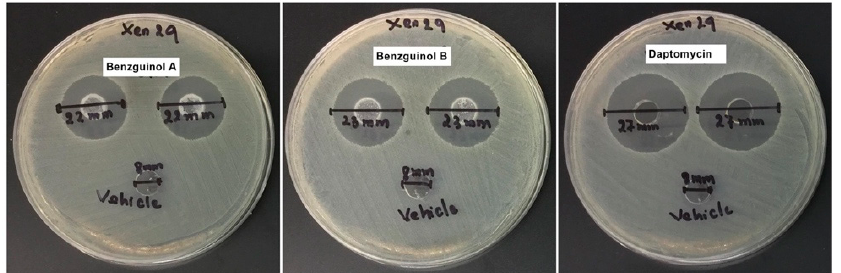
Figure 6. Selected well diffusion of benzguinol A and benzguinol B formulations used in efficacy trial. Each well contained 100 μ L of each formulation of benzguinol A or B (600 μ g) , daptomycin (180 μ g) and 100 μ L vehicle only. Xen29, bioluminescent S. aureus Xen29.